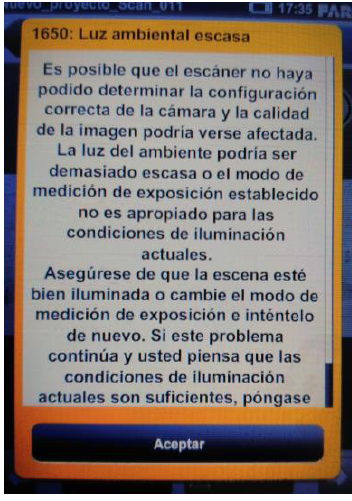
Figure 20. FARO Focus 3D X130 interface. Warning given when colour capturing with laser scanner internal camera in low light conditions 6. RESULTS